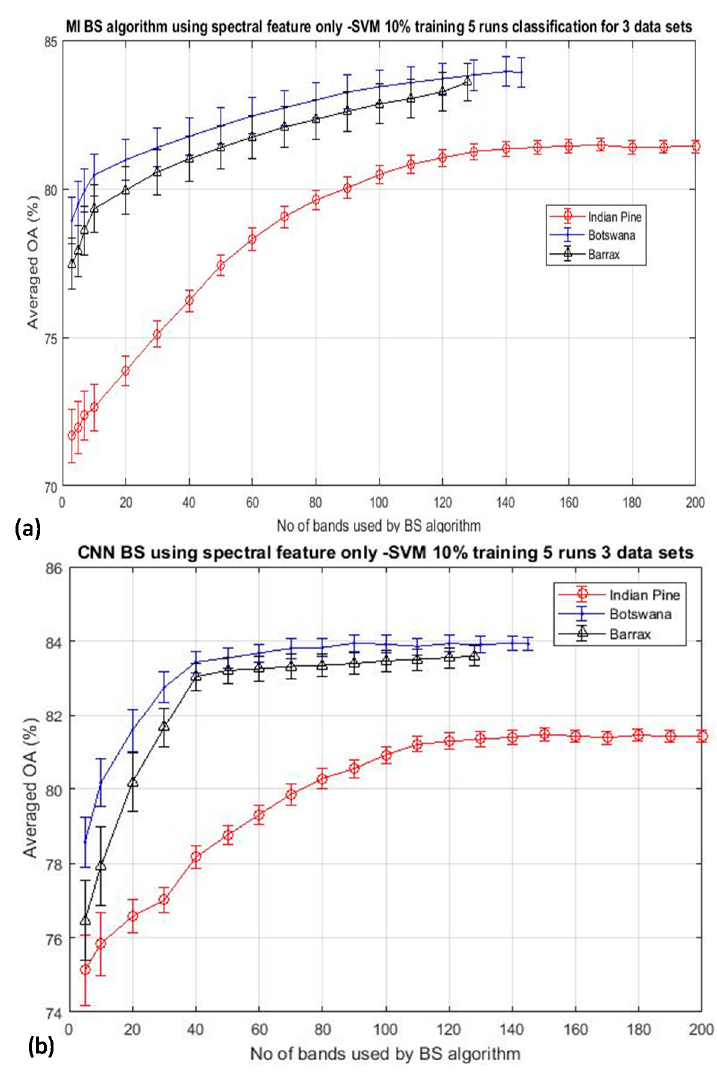
function of the number of bands used for the classification of three datasets. In all cases, 10% of the training data per class have been used throughout all runs: ( a ) mutual information (MI)-based algorithm [17,26], ( b ) Deep learning CNN algorithm [89]. The continuous increasing of accuracy with